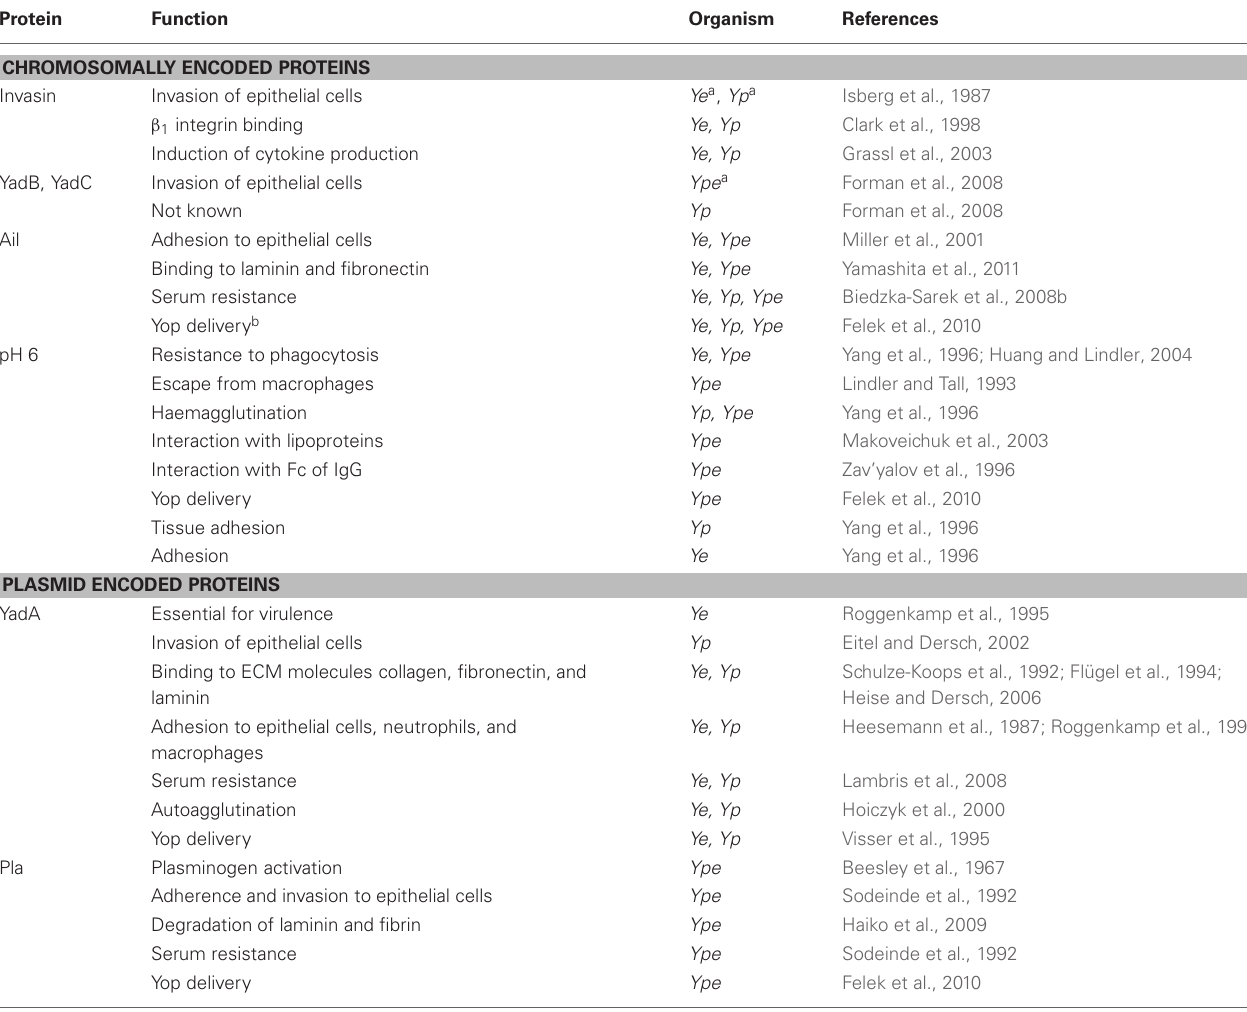
Table 1 | Summary of functions of Yersinia